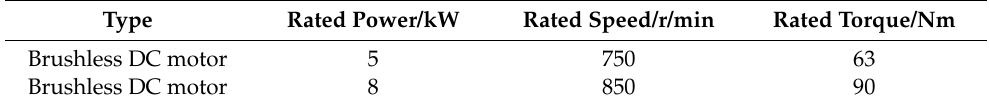
Table 1. Related parameters of the